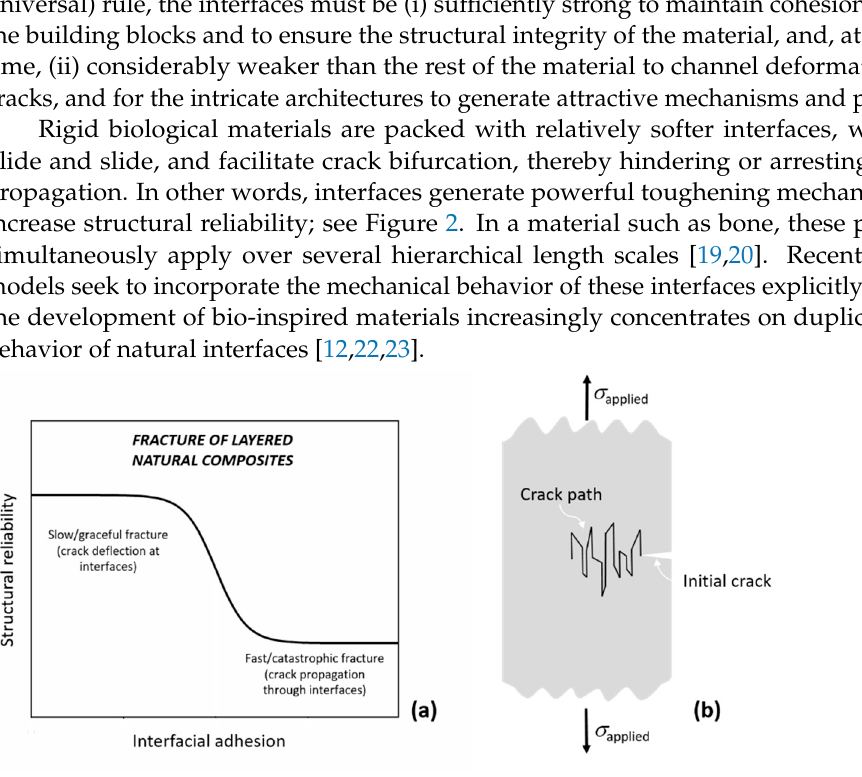
Figure 2. ( a ) Reliability of a layered structure as a function of the level of interfacial adhesion. Cracks do not deflect or stop at strong interfaces (low structural reliability), whereas they bifurcate or even arrest at weak interfaces (high structural reliability), as schematically shown in ( b ).